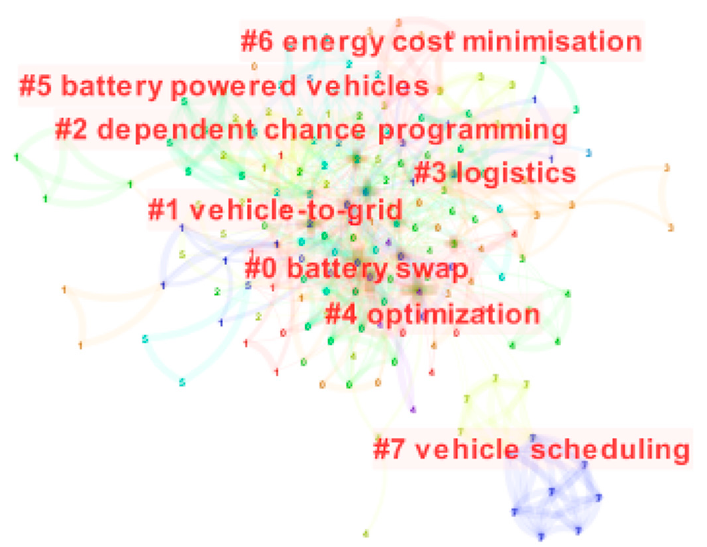
Figure 3. Published number of literature related to the service and operation of BSS.